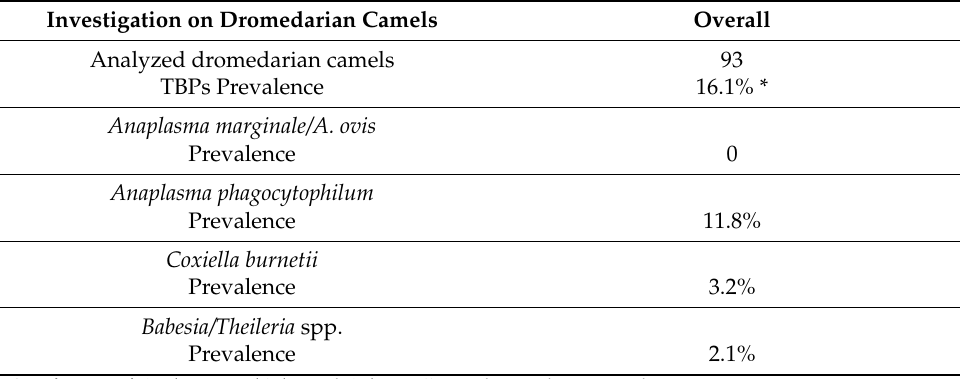
Table 2. Results of molecular investigation on dromedary